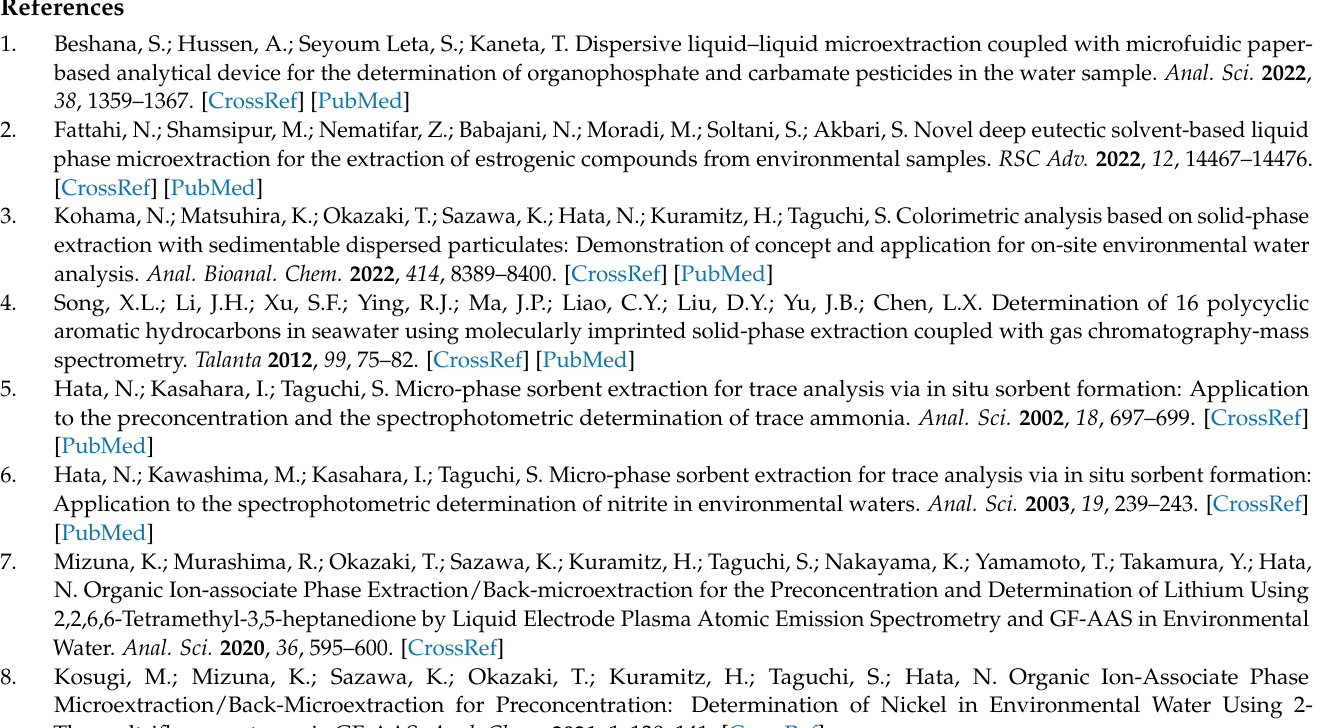
Figure S3: Example of calibration curves for calculating percentage